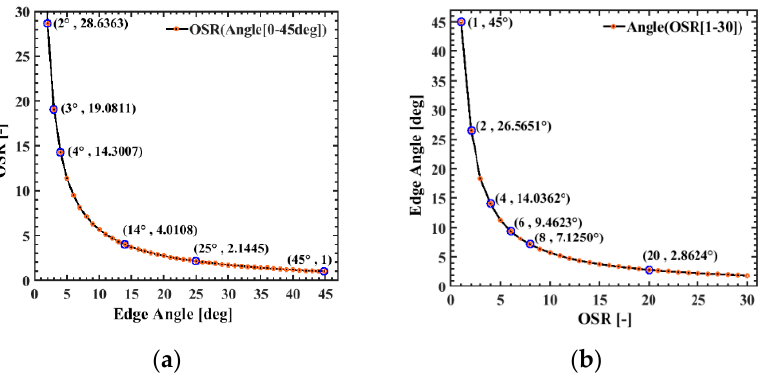
Figure 9. Theoretical relationship between OSR and edge angle: (a) OSR when angle belong to [0, 45] deg and some OSR labels at integral angle, (b) angle when OSR belong to [1, 30] and some angle labels at integral OSR.